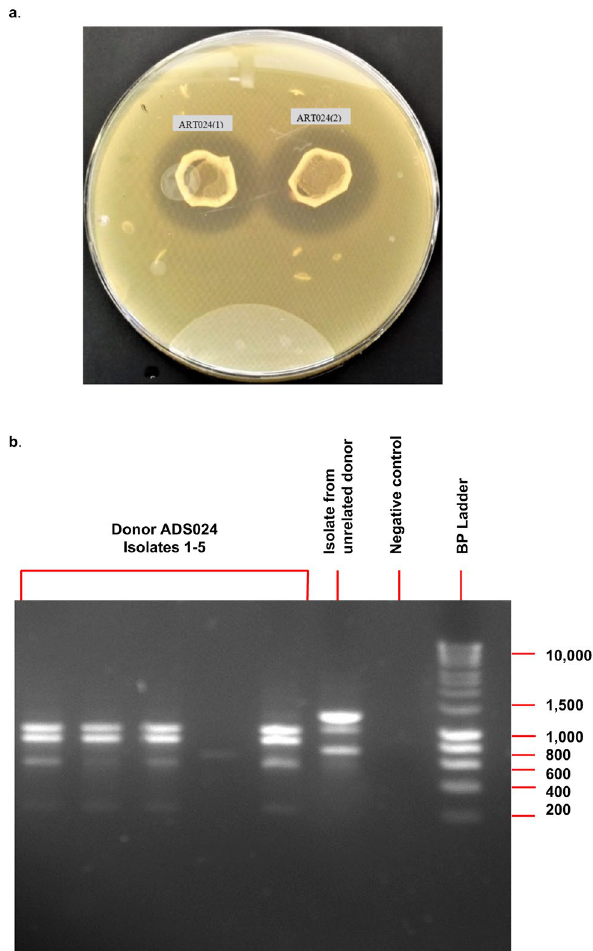
Figure 1. A culture-based screen of fecal samples identified ADS024. ( a ) Representative isolates from a single healthy human donor (ADS024) demonstrating zones of inhibition in a deferred antagonism assay with C. difficile . ( b ) Random amplified polymorphic DNA analysis demonstrating that 4 of the 5 isolates belong to the same bacterial